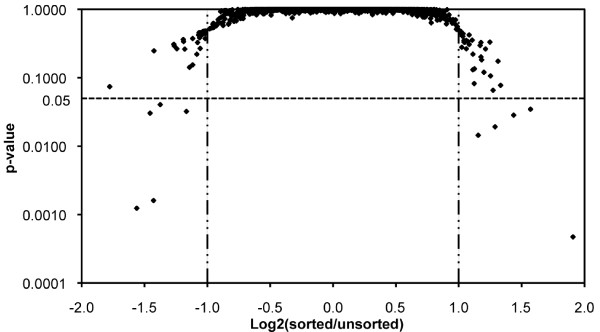
Plot of gene expression of sorted/unsorted cells. Plot of one-sample T-test p-values with fold-change in gene expression for all ORFs in microarray study I. Vertical lines show the cutoff of fold-change of 2 (Log2 ratio of ± 1), while the horizontal line shows the cutoff of p-value 0.05. Genes located in the left-bottom corner (Log2 ratio <-1 and p-value <0.05) and in the right-bottom corner (Log2 ratio >1 and p-value <0.05) were considered to have their expressions changed due to dispersion/homogenization and IMS (immuno-magnetic separation) cell sorting. A total of ten genes were selected using these criteria, eight of which also differentially expressed in the independent microarray study II.